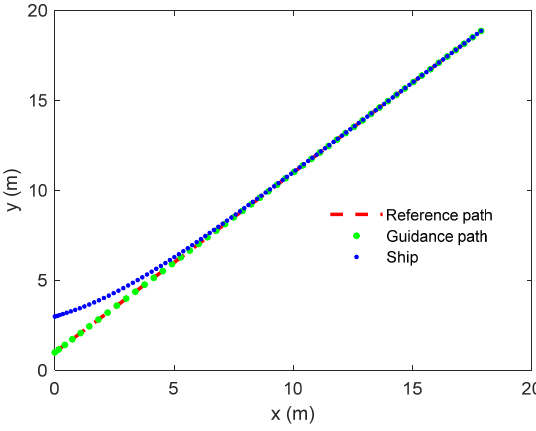
Figure 2. The performance of straight path following.